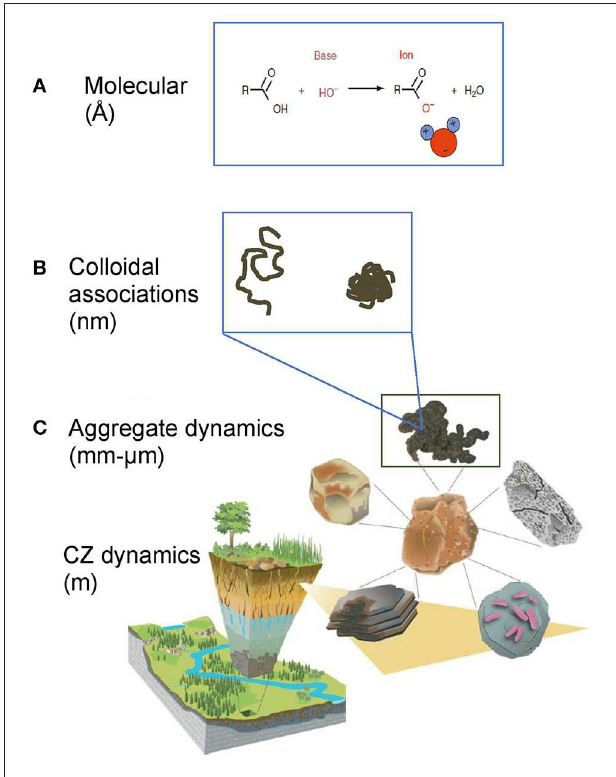
FIGURE 13 | Conceptualization of DOC release at varying scales and mechanisms. (A) Solution chemistry can change DOM solubility (Å-scale) and (B) DOM conformation (nm scale, figure modified after Chorover et al., 2007 with permission from the Mineralogical Society of America and Kleber and Johnson, 2010 with permission from Elsevier). These smaller scale processes would not lead to significant changes in aggregate size. (C) Solution composition could lead to aggregate dispersion and release of dissolved organic matter (DOM, mm- µ m